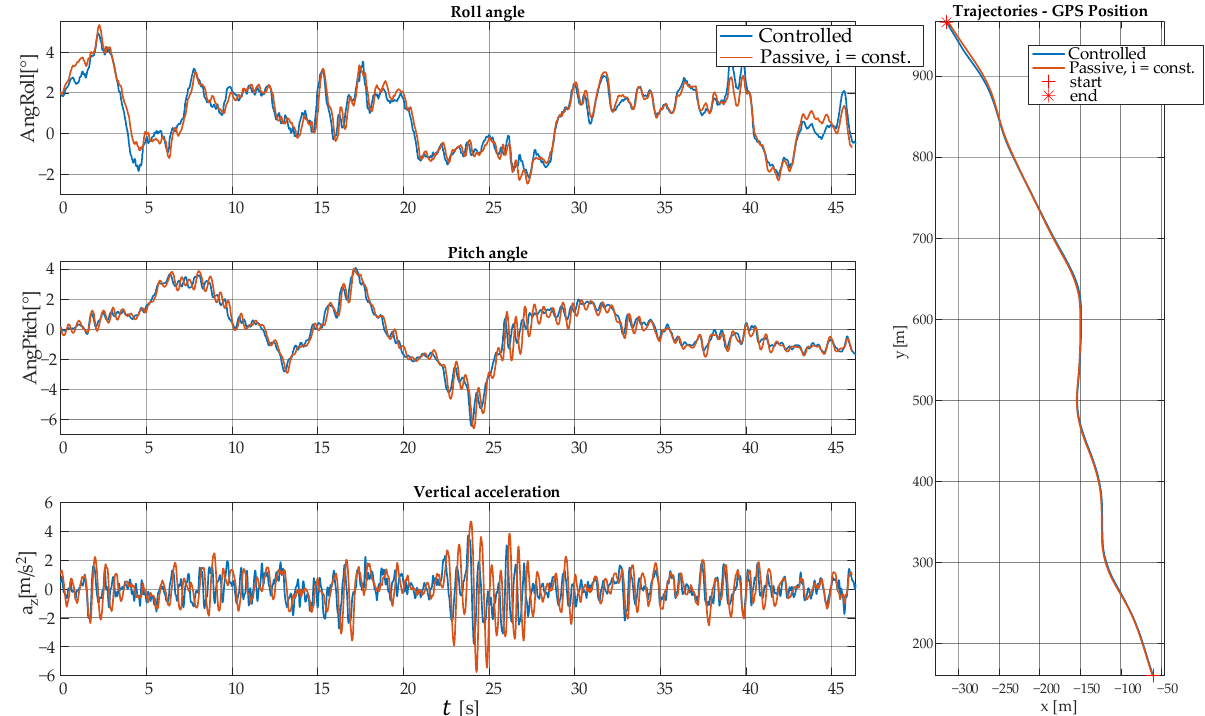
Figure 17. Comparative results from a test maneuver to validate the semi-active damper controller.